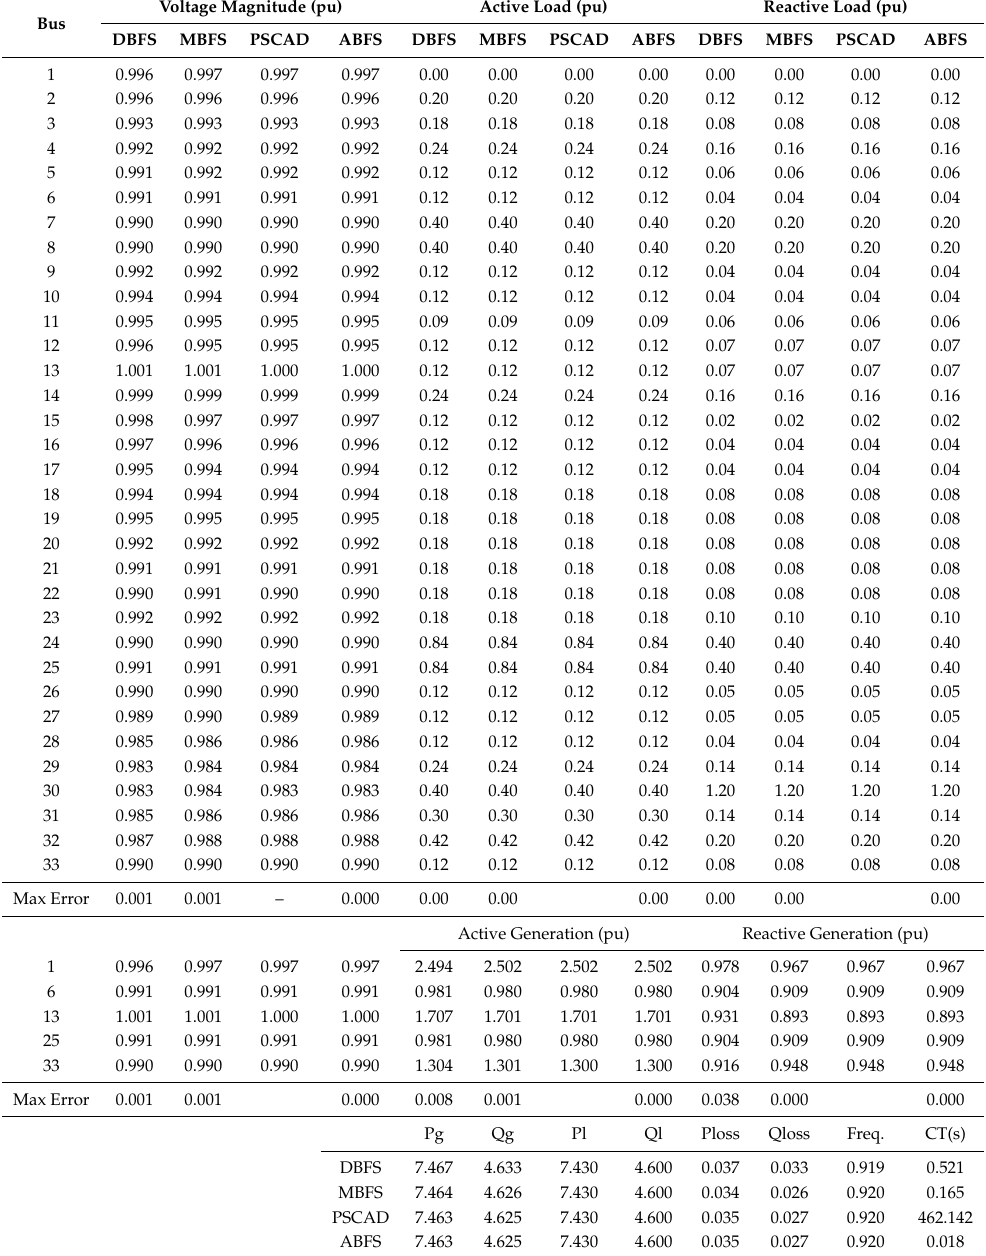
Table 4. ABFS algorithm versus DBFS, MBFS, and PSCAD/EMTDC results for